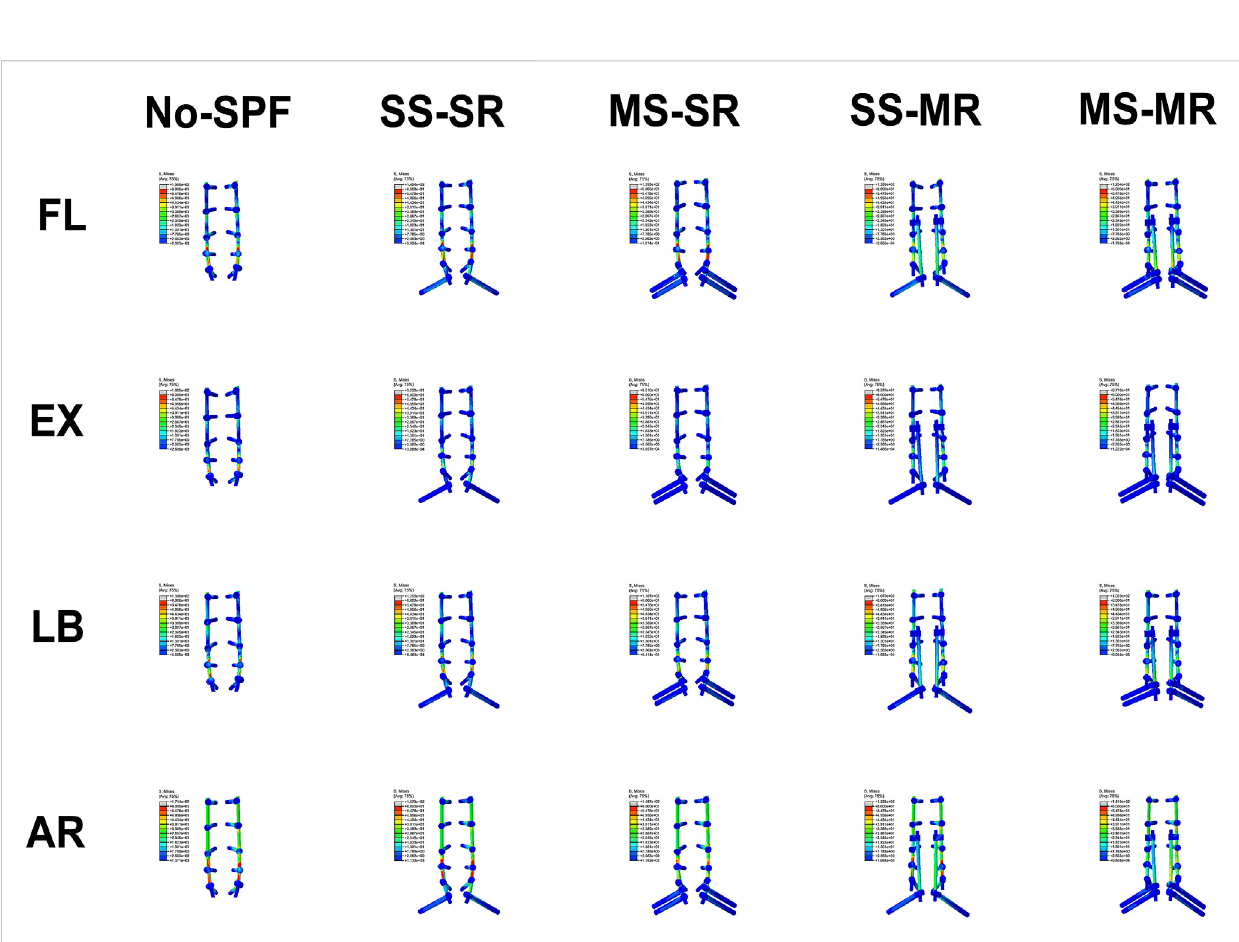
FIGURE 6 Von-Mises stress on instrumentation of different instrumented models in fl exion, extension, lateral bending, and axial rotation.